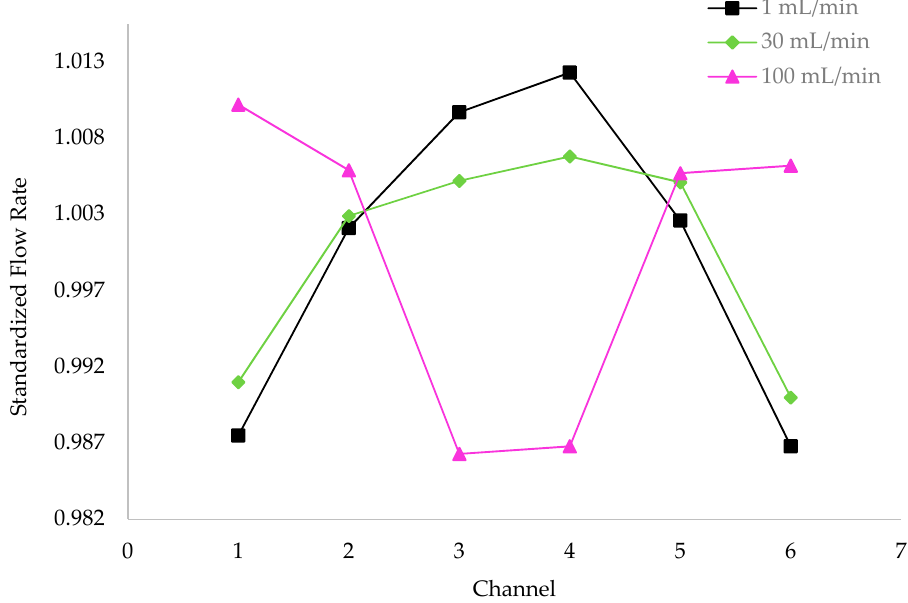
Figure 17. Standardized flow in each channel of the heat sink with triangular-shaped collectors, for different flow rates.